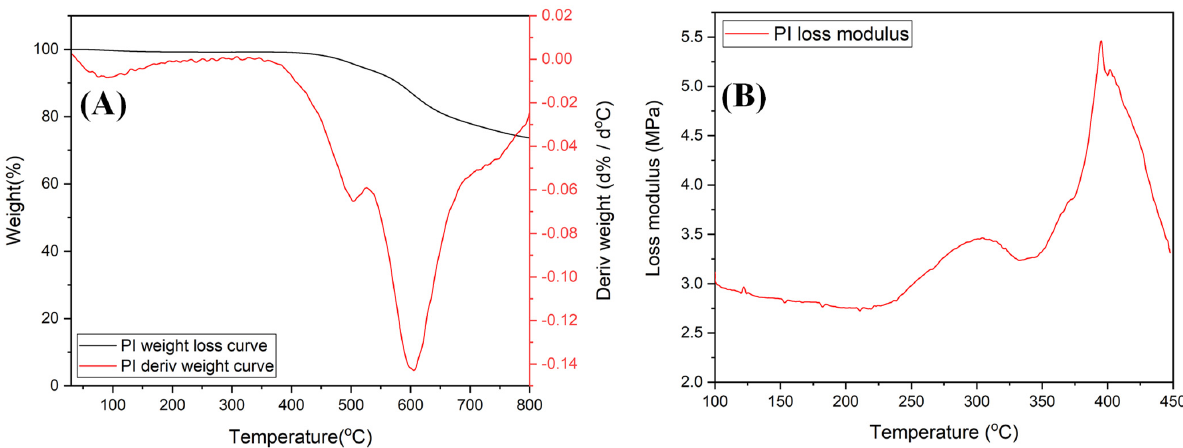
Figure 4. ( A ) TGA and ( B ) DMA curves of BI-PI membrane.